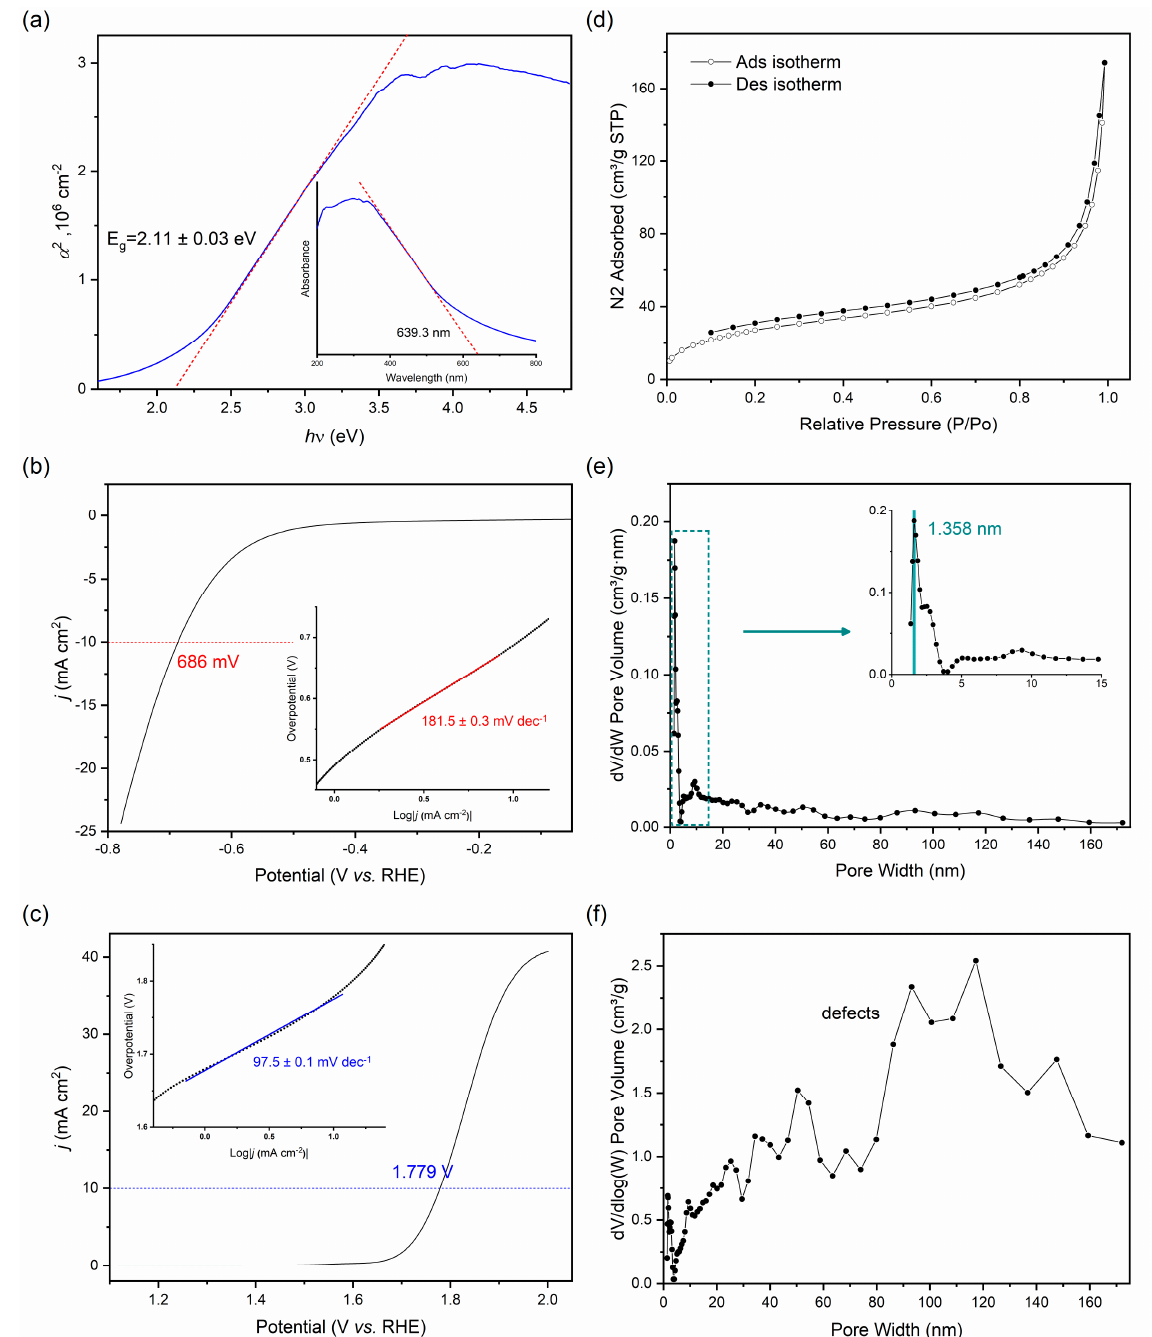
Figure 4. ( a ) Determination of the optical band gap from UV-visible spectrophotometry of the HsGDY powder. ( b , c ) HER ( b ) and OER ( c ) catalytic performance of the HsGDY powder. ( d ) Nitrogen adsorption-desorption isotherm. ( e , f ) Pore width distribution ( e ) and surface area ( f ) for the HsGDY powder, calculated after fitting a DFT model to the adsorption data.